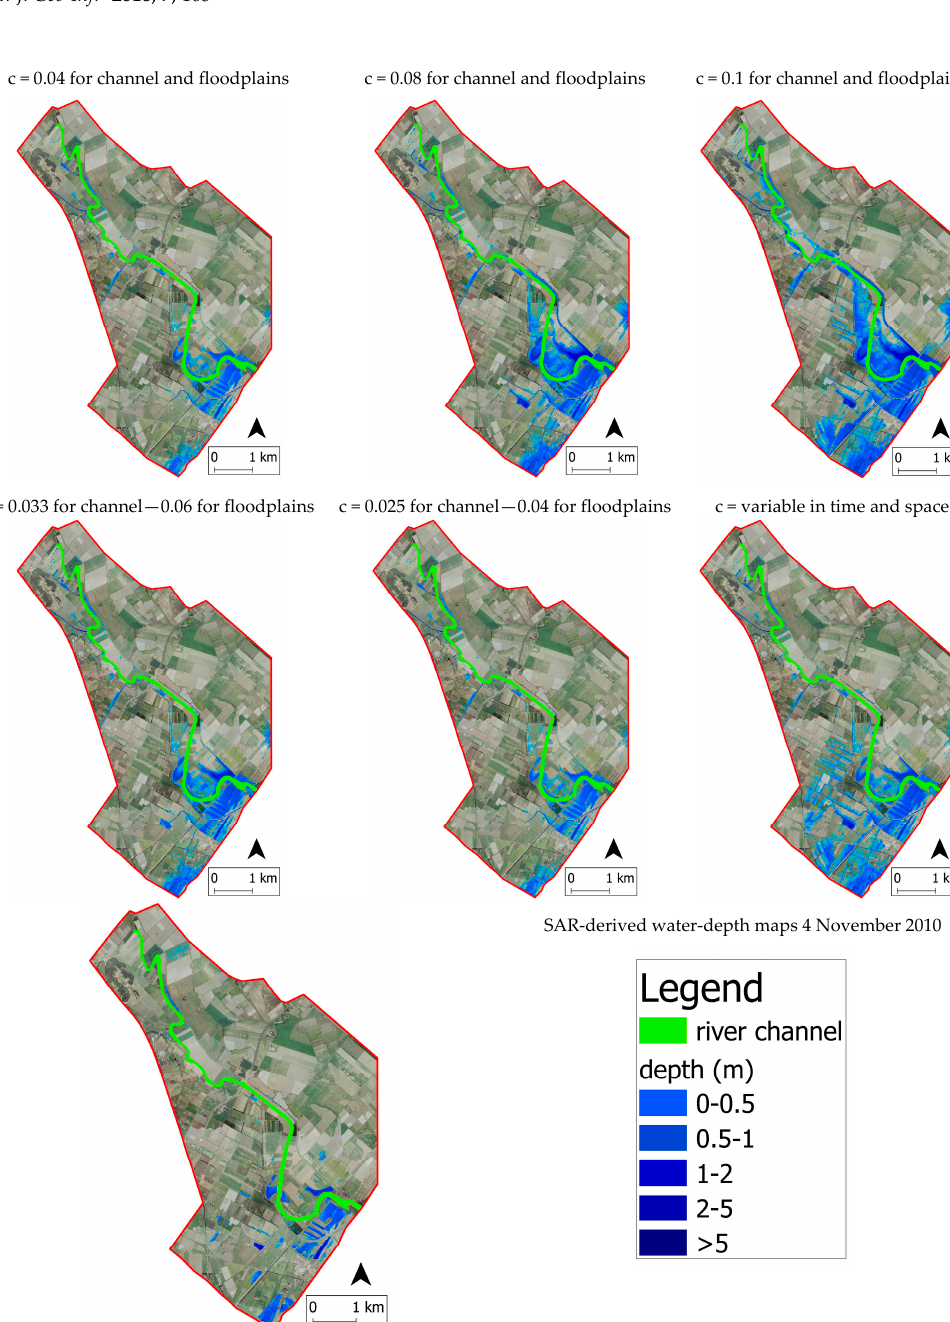
Figure 5. Comparison between the 6 hydrodynamic simulations characterized by a different set of Manning coefficient values and the SAR- and DEM-derived water depth map for 4 November 2010.